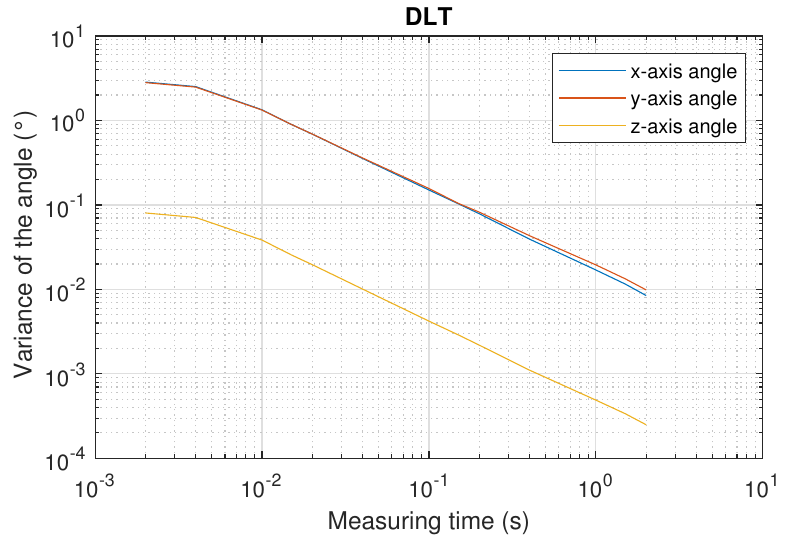
Figure 20. Mean value of the variance of the three axis orientation angles as a function of the measurement time using